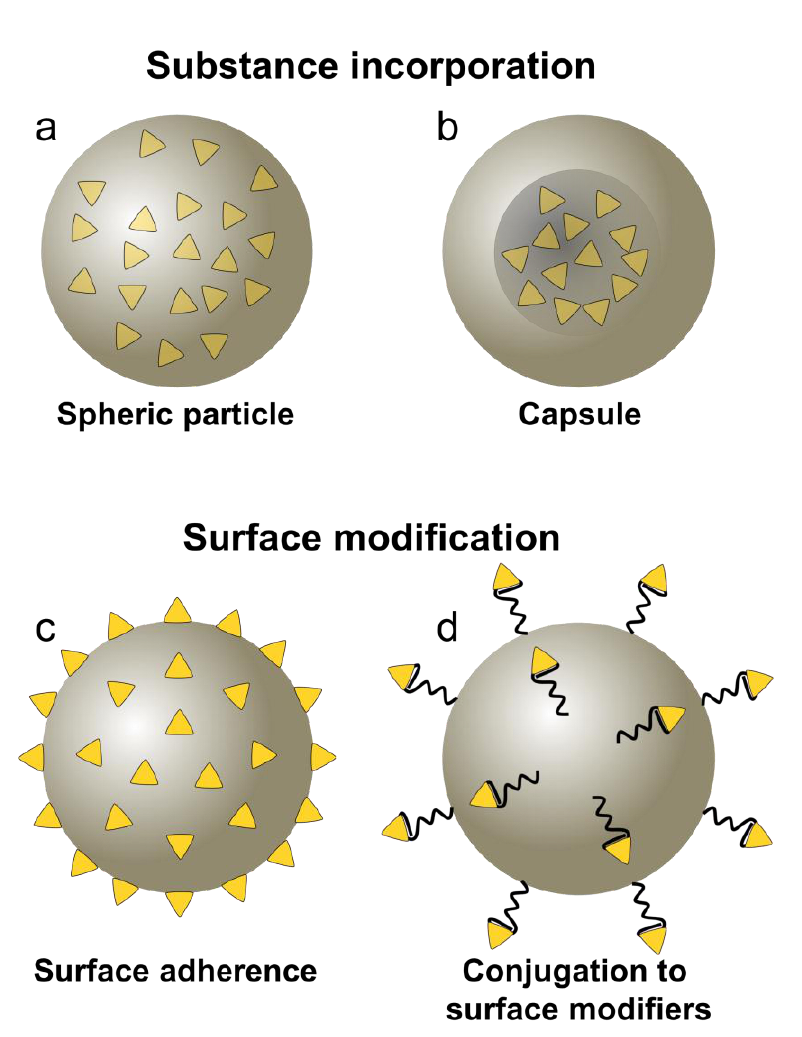
Figure 1. Strategies for particle loading. PLGA particles (gray spheres) can be loaded with substances (yellow triangles) via incorporating them into the particle or loading them onto the particle surface. Substances can be incorporated into PLGA particles via entrapping the molecules into the PLGA matrix of spheric particles ( a ) or encapsulating them into the core of capsules ( b ). Surface loading of cargo molecules can be achieved via adherence to the particle surface ( c ) or by conjugation of the substances to other surface modifiers such as PEG or chemical linkers ( d ).